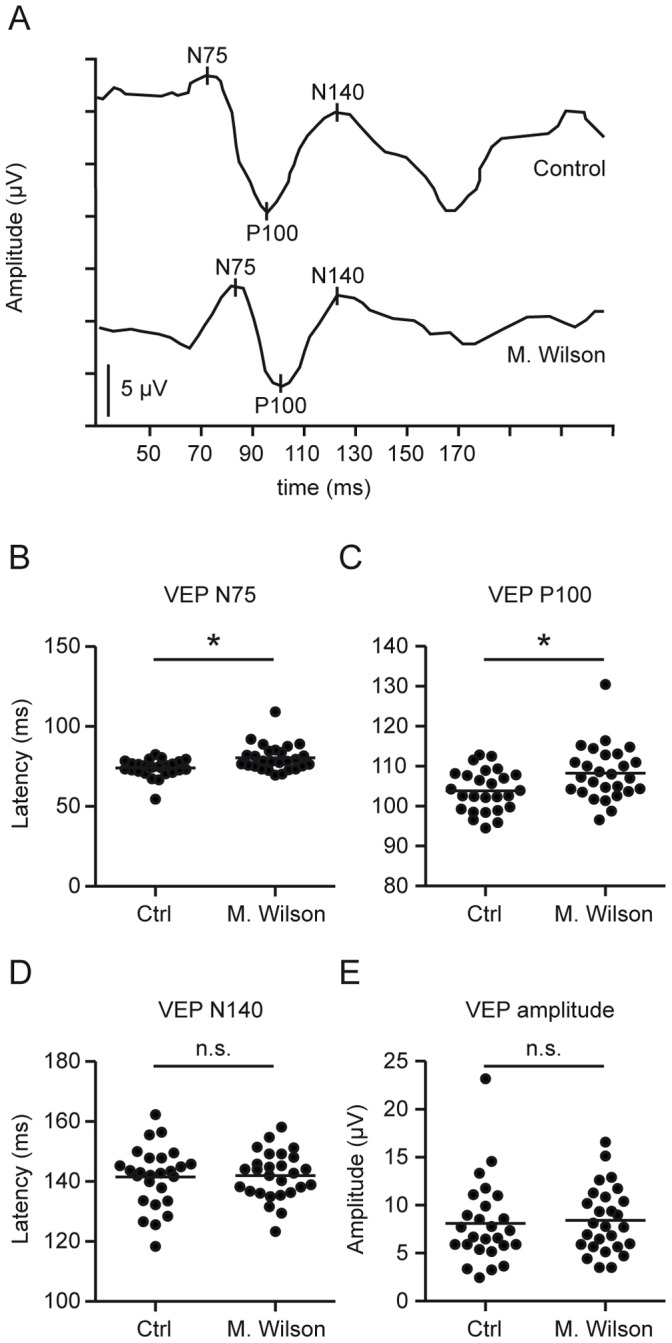
Visual evoked potentials: N75 and P100 latencies are prolonged in Wilson’s disease. ARepresentative VEP curves of Wilson’s disease patients and controls are displayed. B–E Scatter plots of the mean VEP parameters. Each point represents the mean of the two eyes of one patient. The mean of all patients is indicated by a horizontal bar. Significant differences are indicated by asterisks (p<0.05, two-tailed t test); non-significant differences are indicated as n.s.